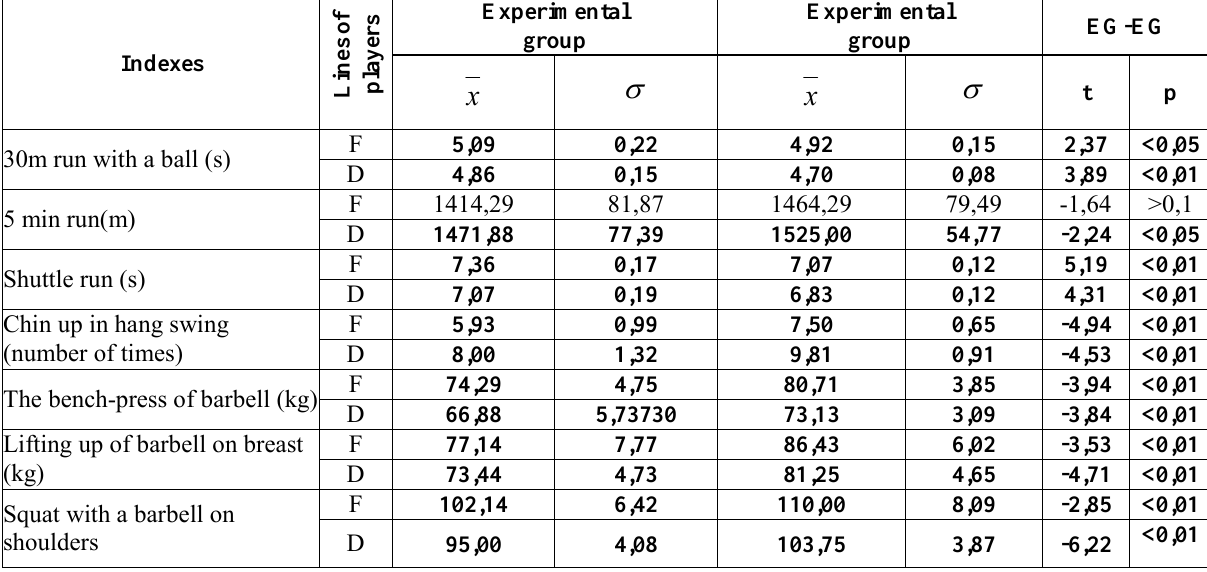
Comparison of indexes of the special physical preparedness on the preliminary stage of experiment and first stage of experiment of experimental group (n=30) of rugby-players aged 16- 17